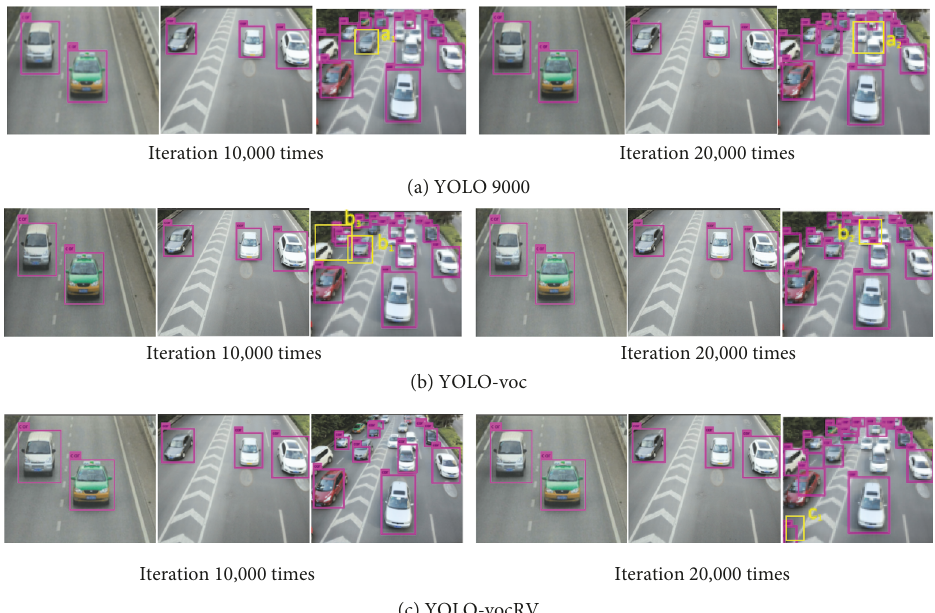
Figure 12: Test results for training samples with free